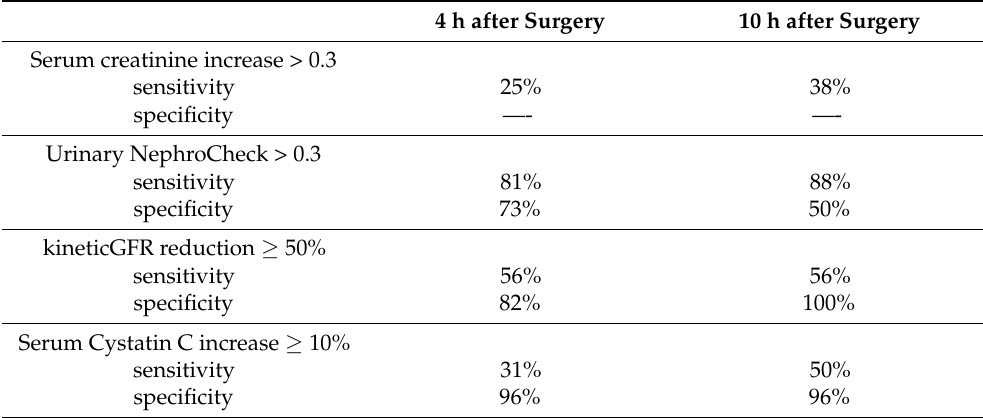
Table 2. Sensitivity and specificity of different promising biomarkers in early predicting postopera- tive AKI. 4 h after Surgery 10 h after Surgery Serum creatinine increase >